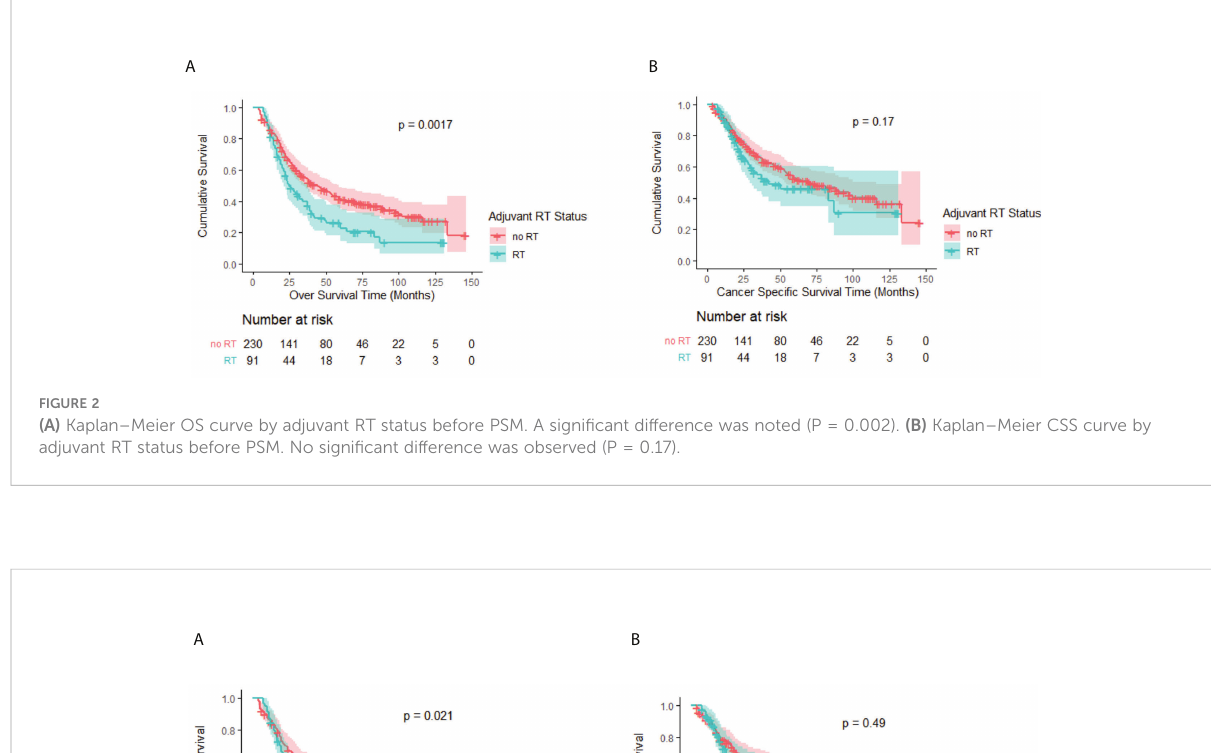
Table 3. On univariate analysis, the factors associated with